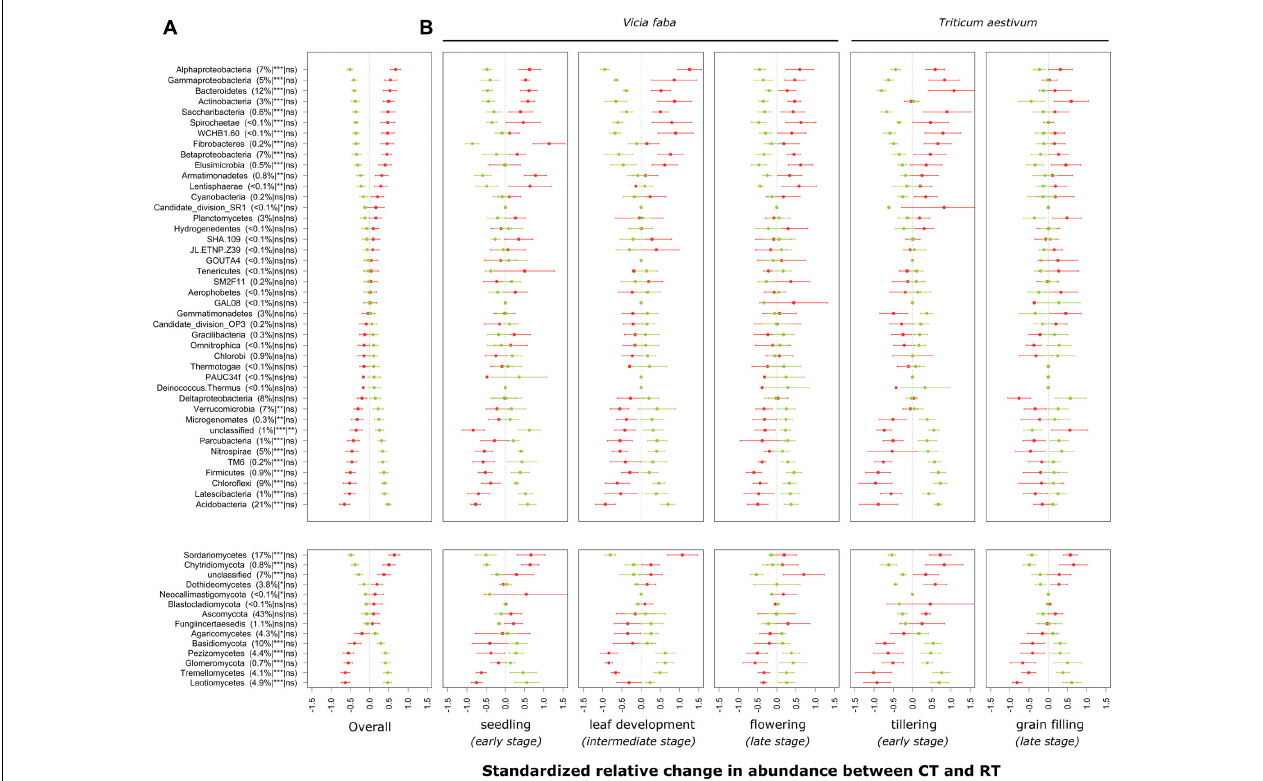
FIGURE 3 | Standardized relative changes in abundance of higher-order taxonomic groups between CT (red) and RT (green) across all growing stages (A) and separately for each individual growing stage (B) . Data were z-transformed, representing values greater or smaller than the average across all samples. The relative abundance as well as the significance of the PERMANOVA test is indicated in brackets: the first argument represents the relative abundance, the second is the significance of tillage effect, and the third represents the significance of the interaction between tillage and growing stage. CT, conventional tillage; RT, reduced tillage; ∗∗∗ q < 0.001, ∗∗ q < 0.01, ∗ q < 0.05; ns, not